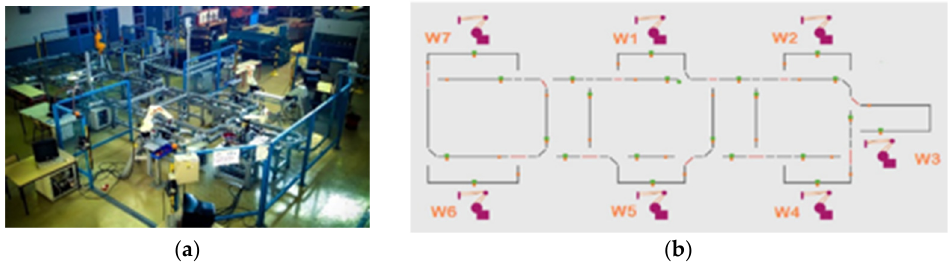
Figure 1. ( a ) The real flexible cell of UPHF. ( b ) Arezzo emulator of the flexible cell.